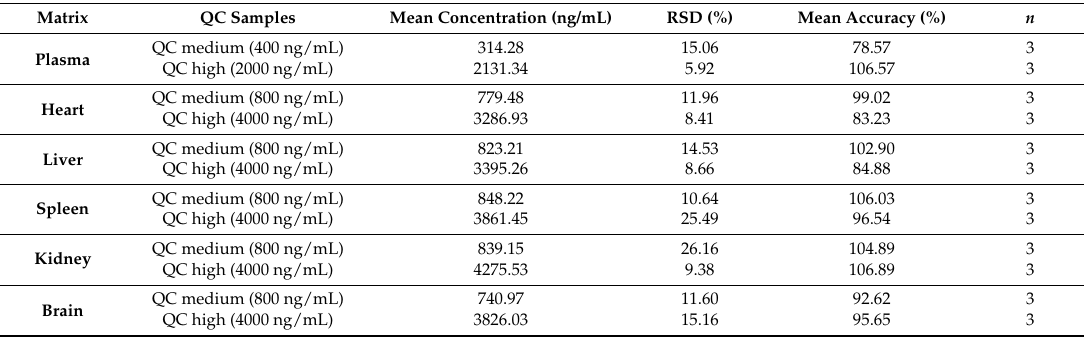
Table 2. Quality control results and statistics from the qualification run for Globotriaosylceramide (GB3).